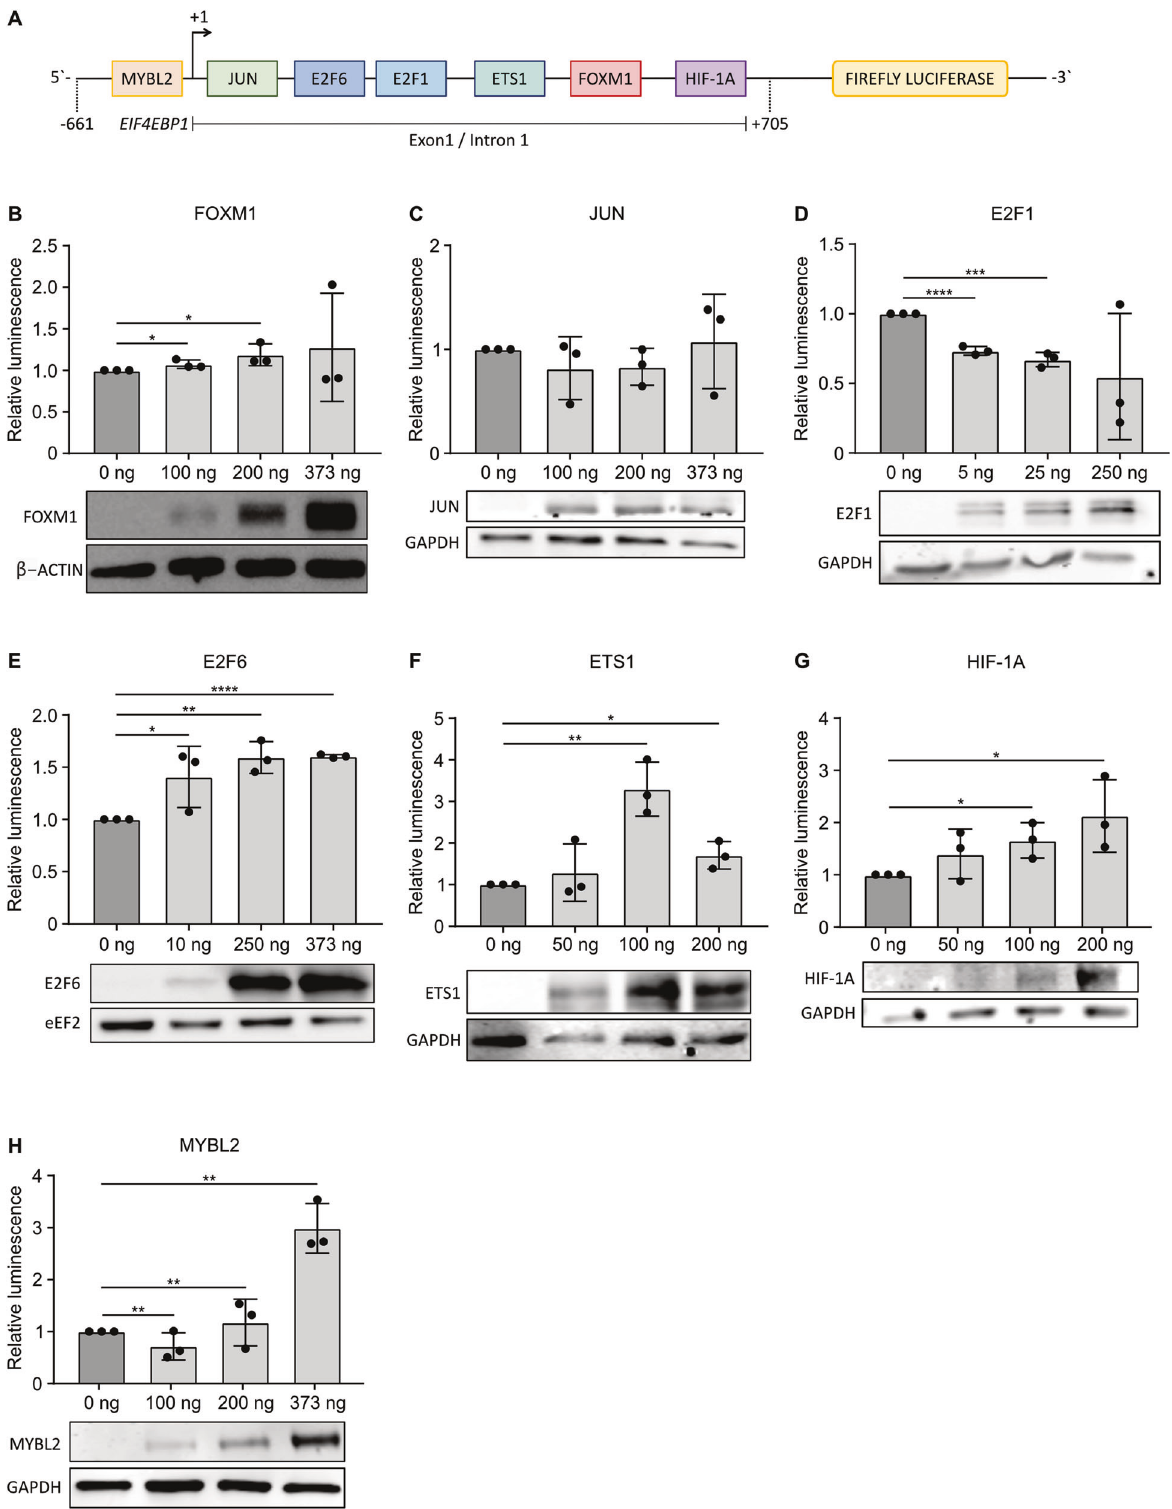
Fig. 3 Induction of EIF4EBP1 promoter activity by E2F6, ETS1, HIF-1A, and MYBL2. A Scheme of the luciferase reporter construct containing the EIF4EBP1 promoter, exon 1, and part of intron 1 ( − 661; + 705), coupled to Fire fl y luciferase, with the indicated binding sites of transcription factor candidates. B – H HEK293-T cells were transfected with the − 661; + 705 EIF4EBP1 promoter reporter construct, together with increasing amounts of plasmids expressing either one of the indicated transcription factors and a vector expressing Renilla luciferase. Luciferase activities were detected using the Dual-Luciferase Reporter Assay. Fire fl y luciferase activity was normalized to Renilla luciferase activity and the ratio was normalized to the corresponding 0 ng condition. Data represent the mean of three independent replicates ± standard deviation (SD). Signi fi cance was calculated using an unpaired and one-tailed parametric t -test (* p < 0.05, ** p < 0.01, *** p < 0.001 **** p < 0.0001). Below each diagram, a representative immunoblot analyzing overexpression of each of the indicated transcription factors is presented. Cell Death Discovery (2022)